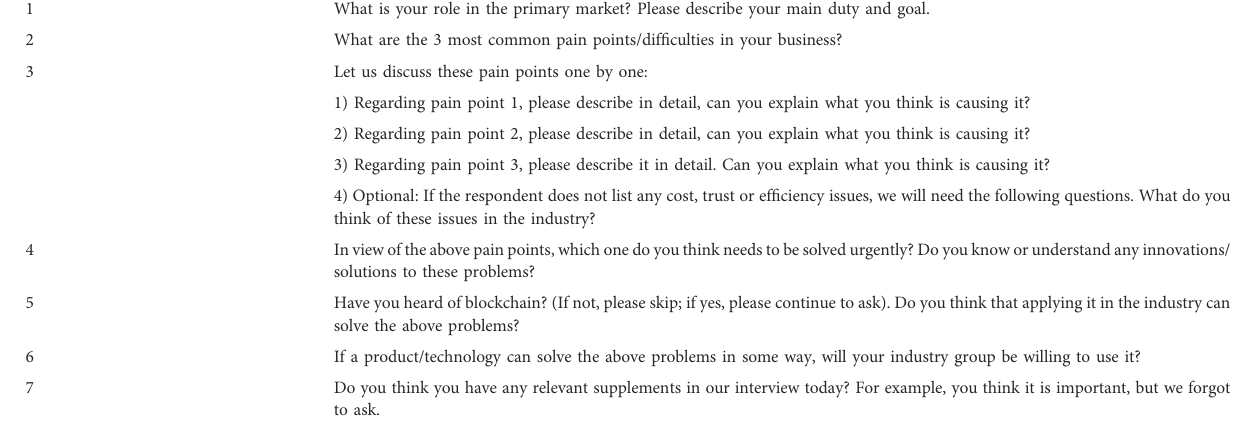
TABLE 1 Problems in primary fi nancial market and solutions from